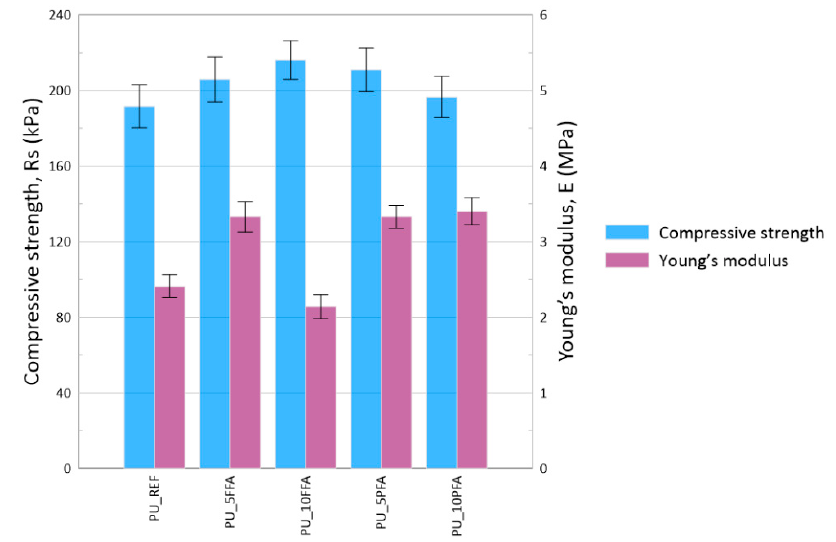
Figure 8. Compressive strength (Rs) and Young’s modulus, E of RPUFs.